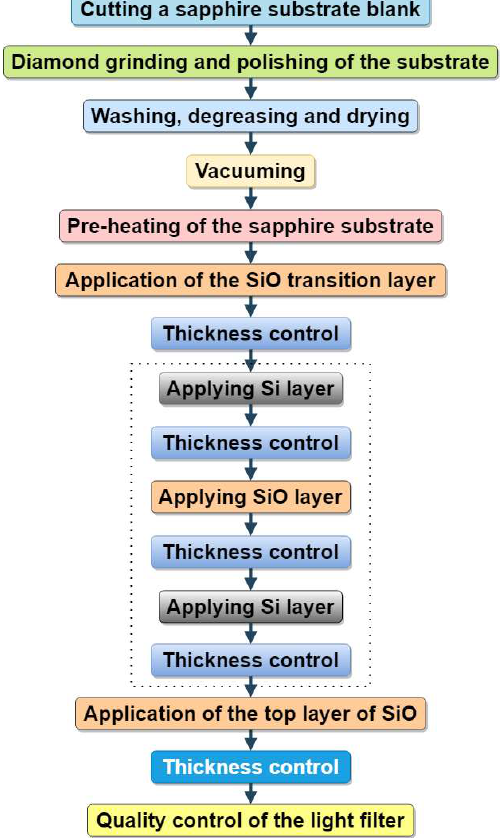
Figure 1. Block diagram of the technological process of forming infrared interference filters.